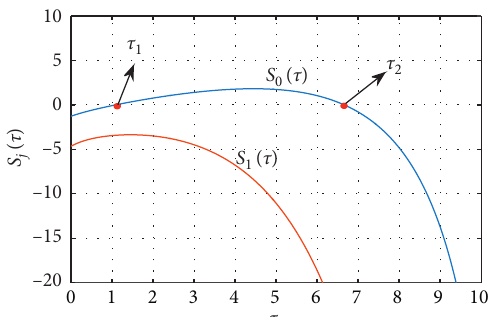
Figure 5: The equilibrium E ∗ of system (4) is stable with τ � 8 . 4.